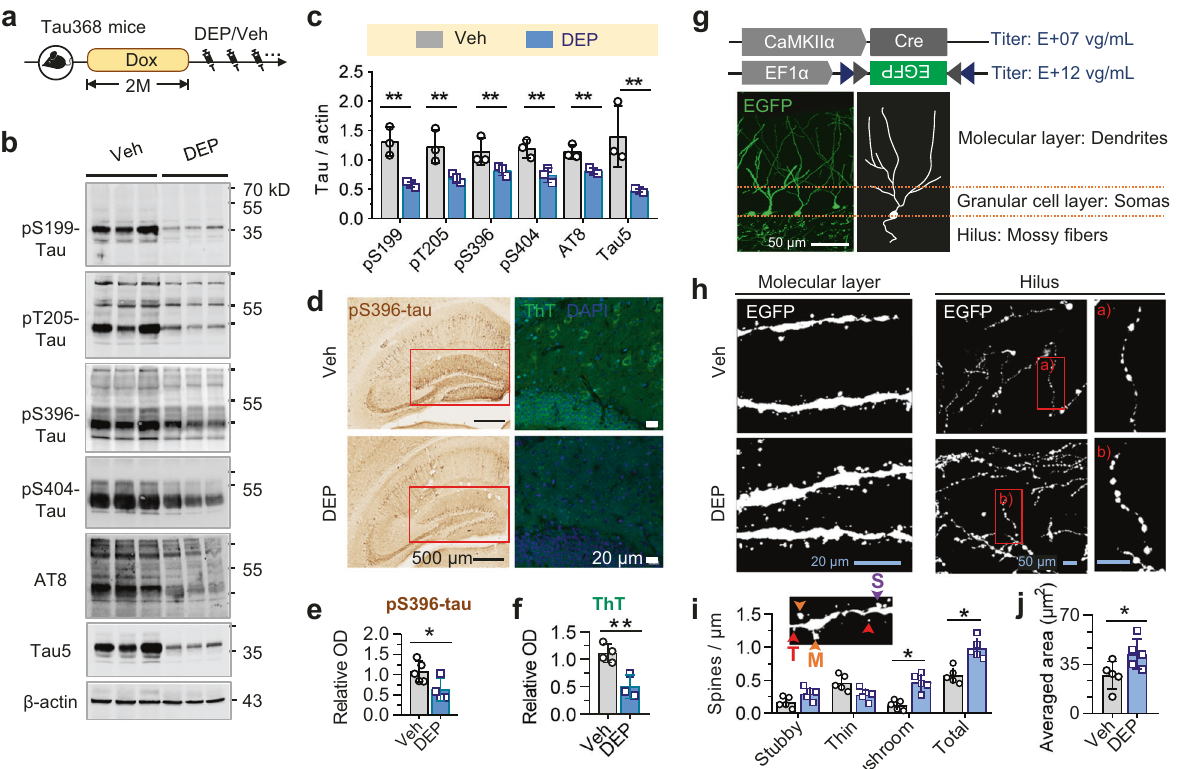
Fig. 4 DEPTAC promotes tau dephosphorylation and improves neurite plasticity in dox-treated Tau368 mice. a Experimental procedure showing that DEPTAC or vehicle was administrated for a consecutive month after stopping the dox. b , c DEPTAC downregulated phospho-tau and total tau levels in the hippocampi of Tau368 mice. Two-way ANOVA followed by Tukey ’ s multiple comparisons tests. ** p < 0.01, n = 3 mice in each group. d – f DEPTAC ameliorated the level of pS396-tau immunostaining ( e ) and thio fl avin T (ThT)-stained tau aggregation ( f ) in the DG subset (red boxes). Unpaired t -tests, ** p < 0.01, n = 4 – 5 mice in each group. ( g ) Sparse labeling of dentate granular cells by a mixture of AAVs. h – j DEPTAC increased the densities of overall and the mushroom-like dendritic spines ( i ) and averaged area of mossy fi ber puncta ( j ) of granular cells. The insert ( i ) illustrated the morphology of different types of dendrite spines: T thin, M mushroom-like, S stubby. Two-way ANOVA followed by Tukey ’ s multiple comparisons tests or unpaired t -tests, * p < 0.05, n = 5 mice in each group